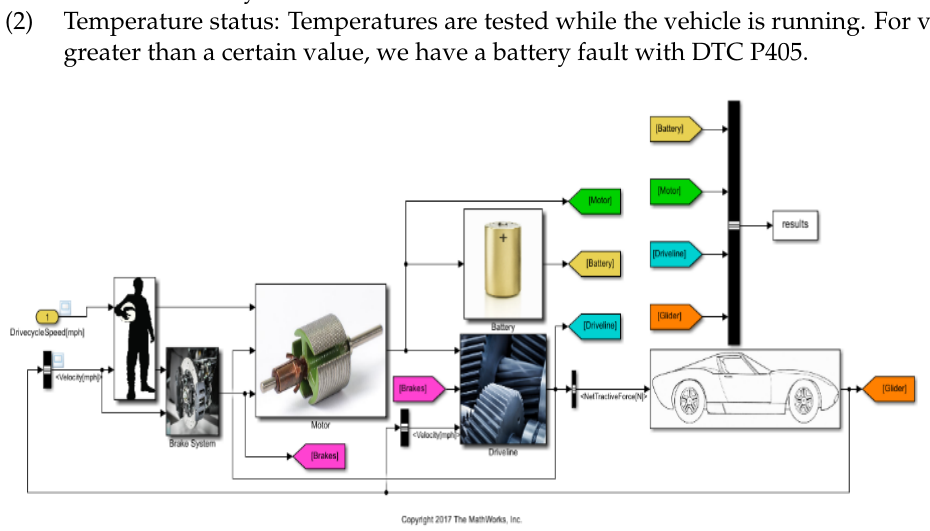
Figure 14. A simulation of a vehicle sending with periodic rate to the Blockchain using